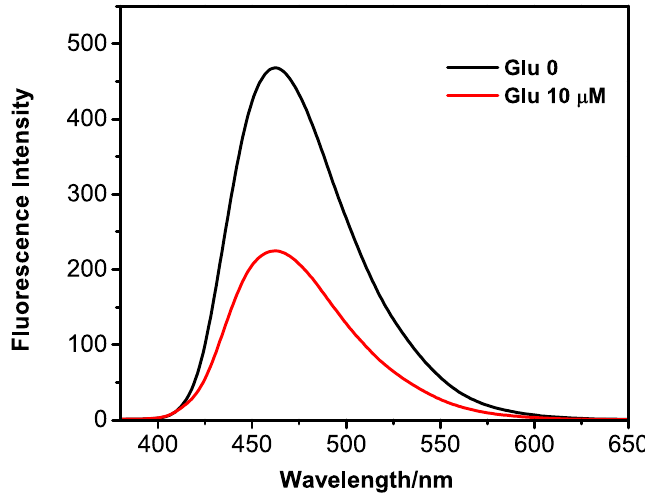
Figure 3. The effect of components of glucose and biosensor on the PL intensity of GQDs: (Black) GQDs–GOx–HRP–phenol; and (Red) GQDs–GOx–HRP–phenol with glucose